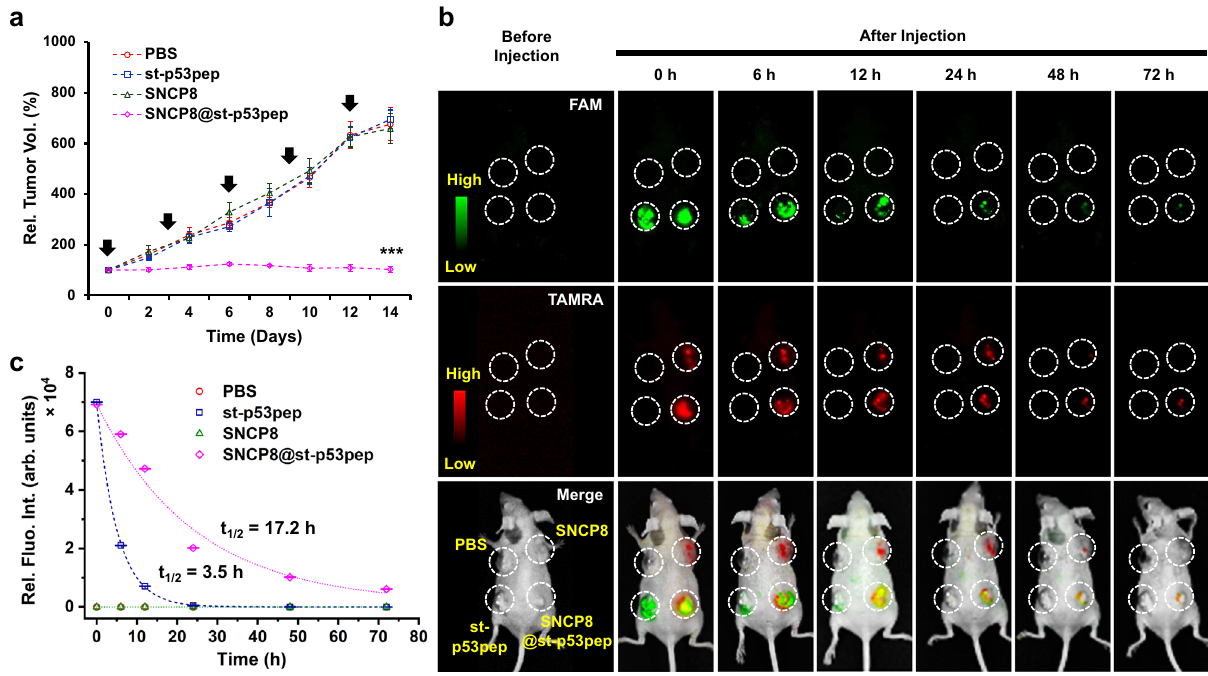
Fig. 5 | Therapeutic ef fi cacy of SNCP8@st-p53pep investigated in a tumor mouse model and whole body imaging of mice treated with SNCP8@st- p53pep. a Time-dependent relative tumor volume of mice after injection with SNCP8@st-p53pep and its comparative groups ( n =3, biologically independent animals;3daysinterval;mean±SD;*** p <0.001,unpaired t test,Theexact p values are provided in the Source Data fi le; red circle: PBS, blue square: st-53pep, green